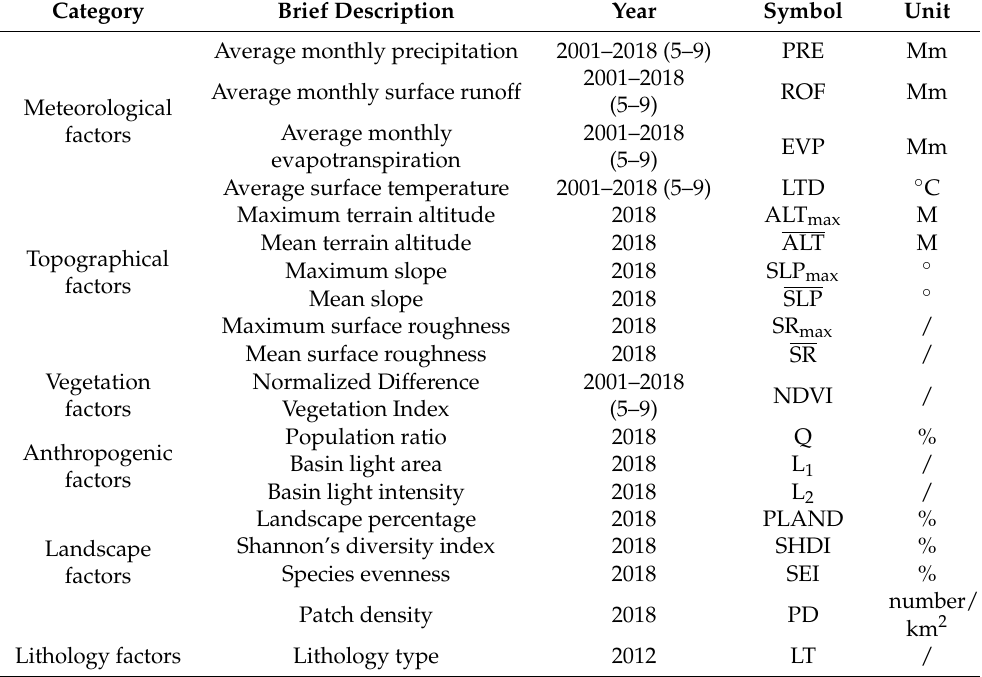
Table 1. List of possible predictor